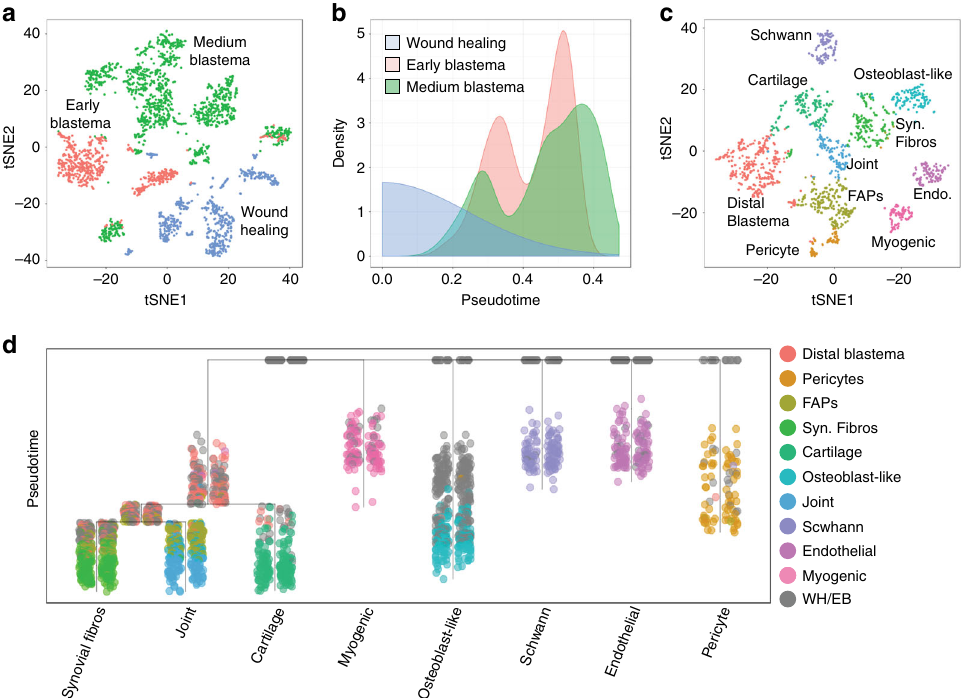
Fig. 7 Putative differentiation trajectories of blastema cells. a t-SNE plot of blastema cells colored by respective time point sampled. b Distribution of pseudotime of blastema cells colored by time point sampled. c t-SNE plot of blastema cell populations in the medium-bud-stage blastema. d Blastema differentiation trajectories colored by blastema cell populations identi fi ed in c . Syn. fi bros synovial fi broblasts, Endo. endothelial cells, FAPs fi bro-adipogenic progenitors, WH wound healing, EB early-bud